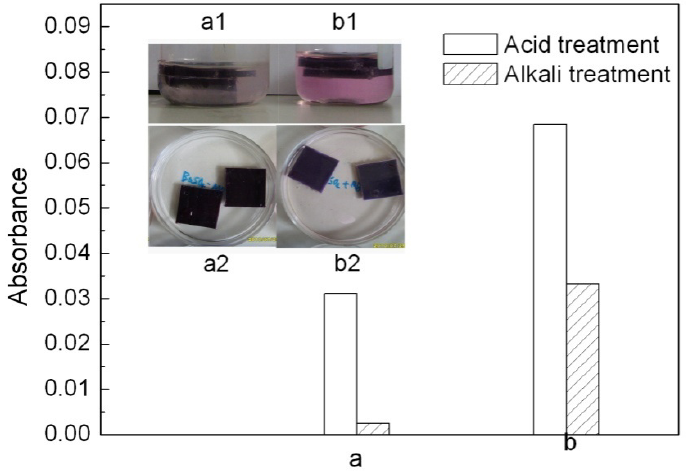
Figure 11. Change of the PP samples colored with the BaSO /MB mixture (b) when immersed in 2% NaOH ( a1, b1 ) and 2% HCl ( a2, b2 ). a and BaSO 4 b: change of absorbance of the solvents determined at 523 nm for MB by